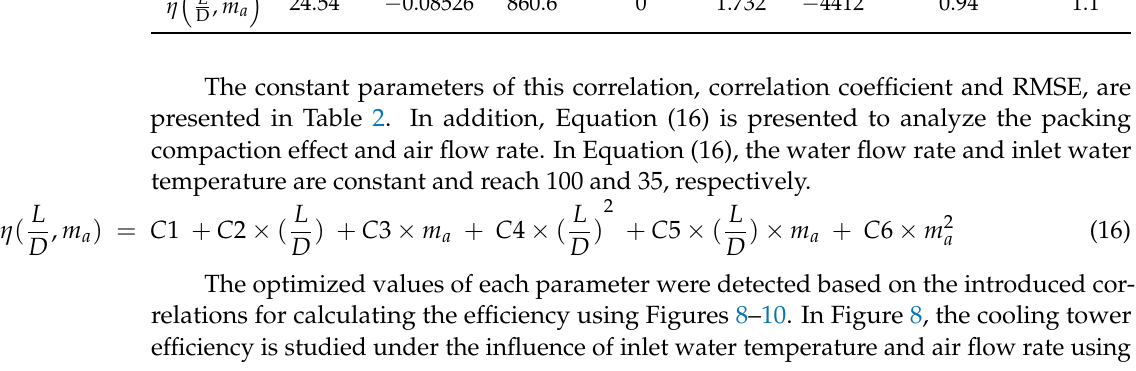
Table 2. Constant parameters, correlation coefficient, and RMSE for Equations (10)–(12).